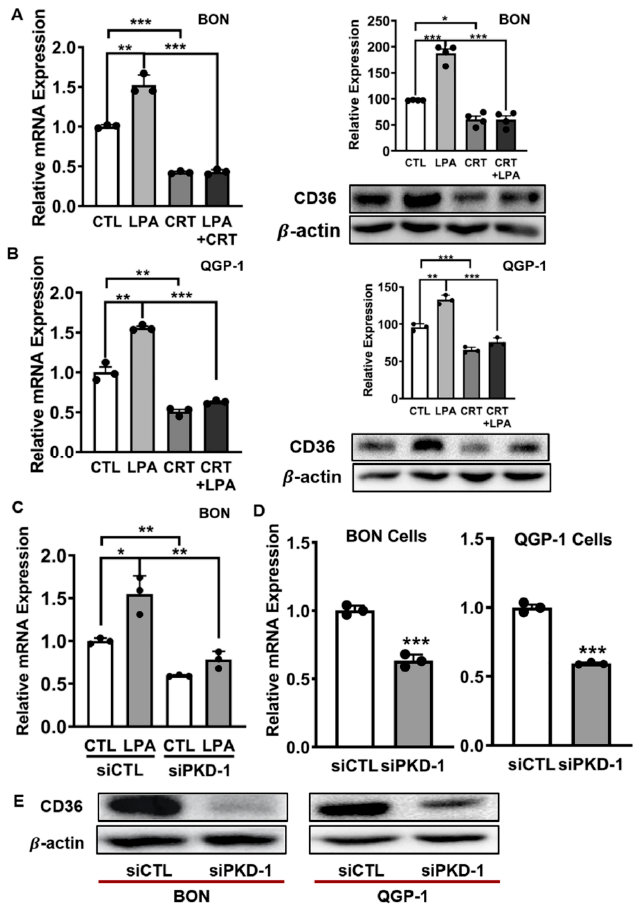
Figure 6. Regulation of CD36 expression by PKD1 signaling in pNET cells. ( A ) BON cells were ex- posed to 10 µM LPA, 2 µM CRT0066101, or their combination, for 24 h. Total RNA was isolated for CD36 gene expression by RT-qPCR (left panel), and cell lysates were collected and subjected to Western blot for CD36 protein expression (right panel). ( B ) QGP-1 cells were treated and assayed for CD36 gene and protein expression as ( A ). ( C ) BON cells were transfected with scramble control or PKD1 siRNA for 24 h, followed by treatment with 10 µM LPA for an additional 24 h. Total RNA was isolated for CD36 gene expression by RT-qPCR. ( D ) The pNET cells were transfected with scramble control or PKD1 siRNA to knock down endogenous PKD1 gene expression, and total RNA was isolated for CD36 gene expression by RT-qPCR. ( E ) The pNET cells were transfected with scramble control or PKD1 siRNA to knock down endogenous PKD1 gene expression, and cell ly- sates were collected and subjected to Western blotting for CD36 protein levels. Shown are repre- sentative images. CD36 protein levels were assessed by densitometry with NIH Image J. Triplicate experiments were performed. * P < 0.05, ** P < 0.01, and *** P < 0.001.